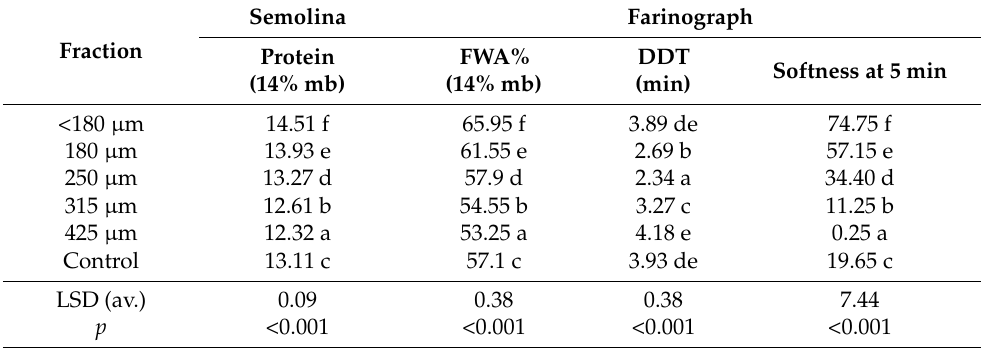
Table 1. Effect of semolina particle size on semolina and dough properties.